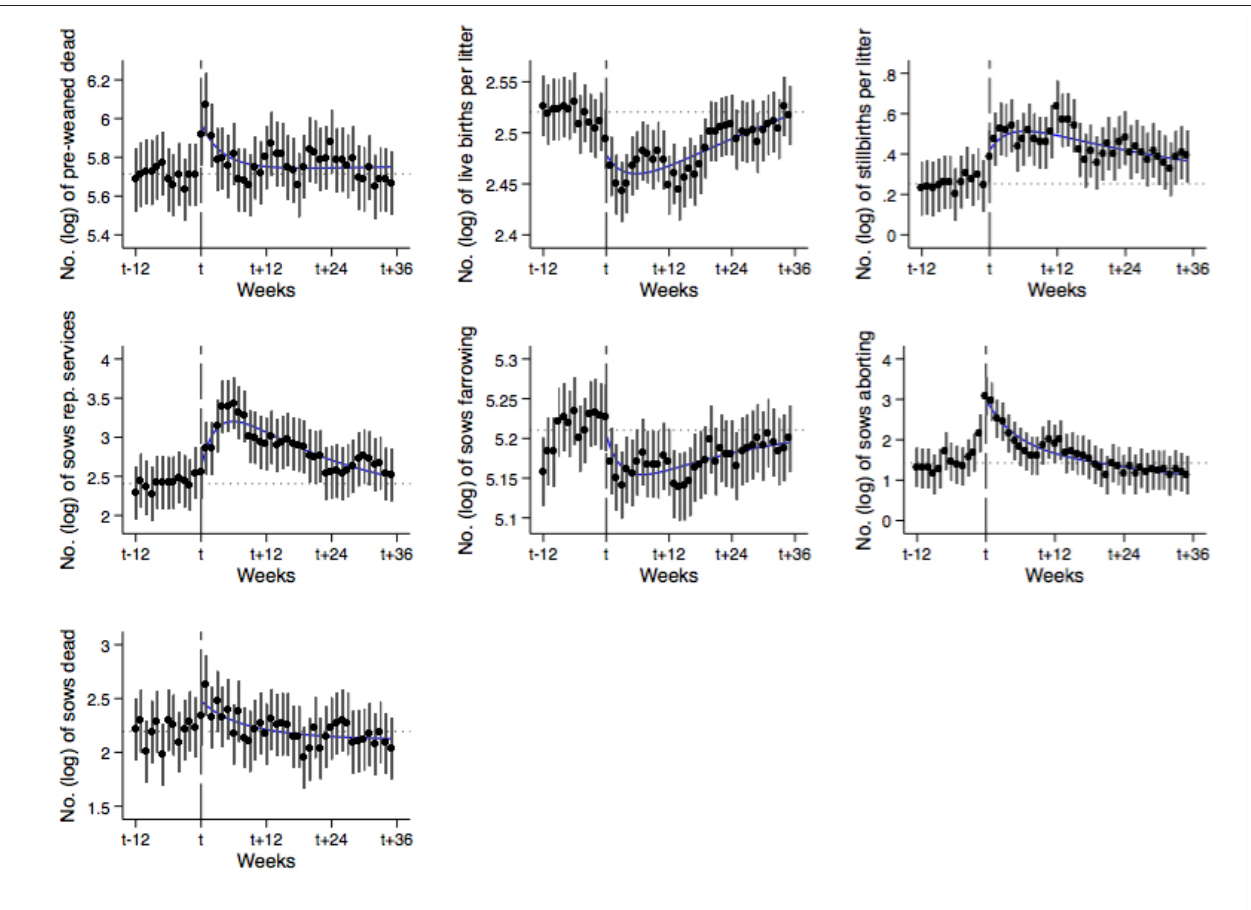
FigUre 4 | Means of fitted numbers (log) of the seven performance indicators during pre- and post-outbreak period ( table s2 ). The horizontal dotted lines show the estimated baselines of each indicator ( Table 1 ). The smooth blue lines show a 4th degree polynomial function that fits estimated means number (log) for each indicator during the post-outbreak period ( t to t + 35). Vertical lines indicate 95% confidence